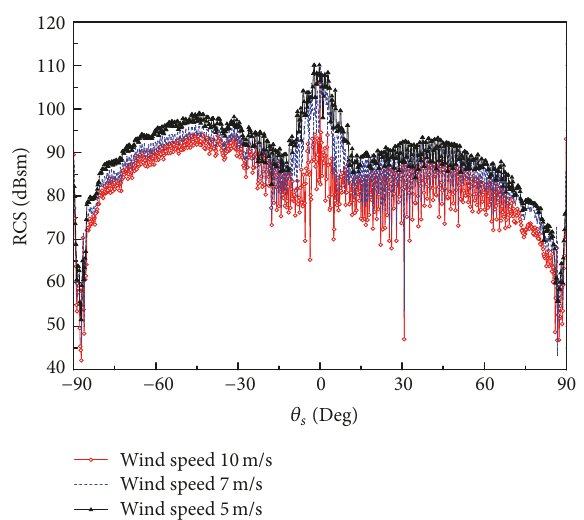
Figure 16: Monostatic RCS results for HH-polarization of the ship- ocean model at different wind